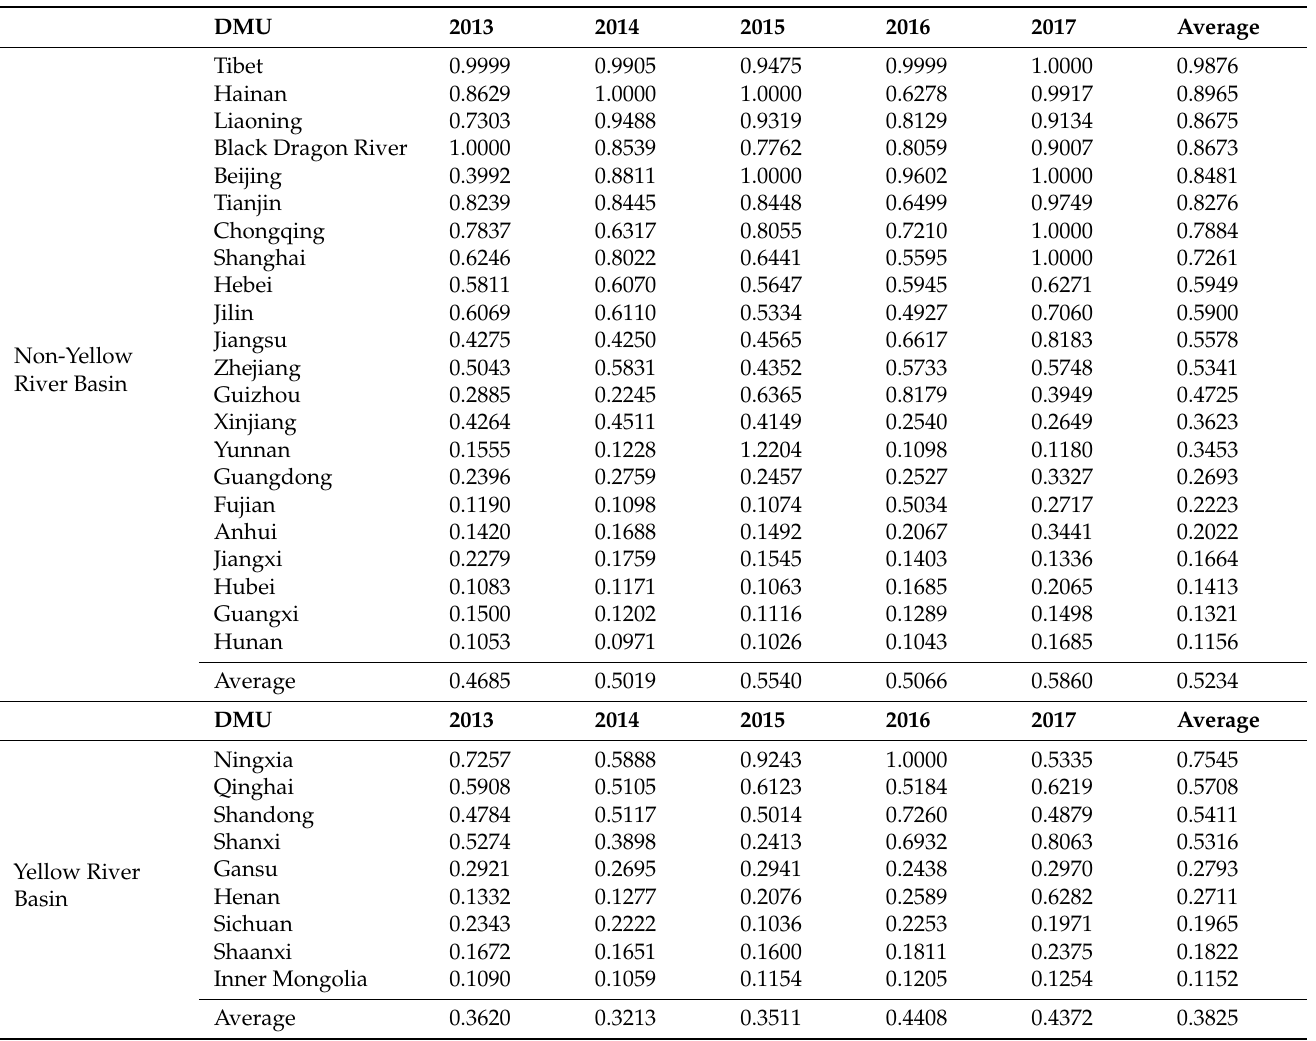
Table A2. TGR analysis of the Yellow River and Non-Yellow River basins from 2013 to